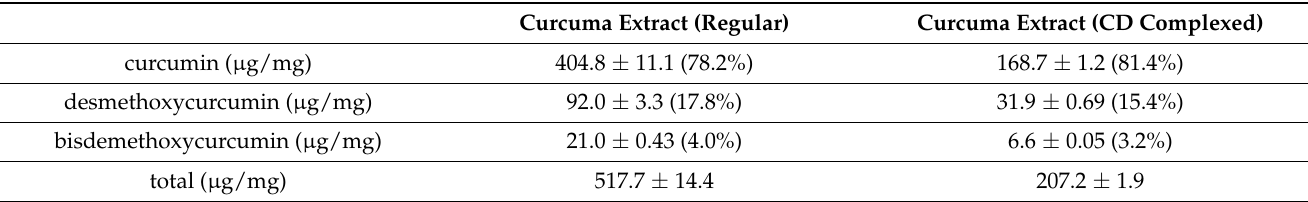
Table 1. Content of the main curcuminoids in regular and CD-complexed curcuma extracts. Curcuma Extract (Regular) Curcuma Extract (CD